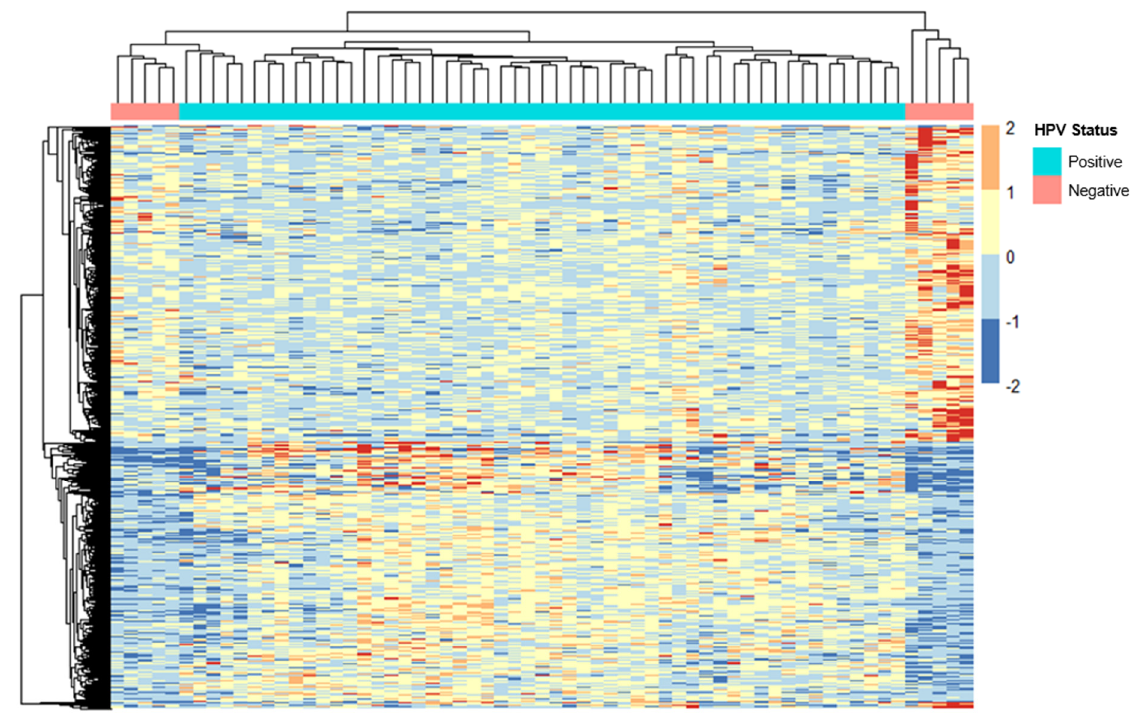
Figure 3. Transcriptome analysis of ERVs in HPV-positive and -negative cervical cancer patients. Heatmap generated using the normalized expression values for ERVs from the Human Endogenous Retrovirus database (HERVd). The plot above depicts the most significant ERVs ( p adj < 0.1) that were differentially expressed among samples with differing HPV diagnoses. The plot above depicts the most significant ERVs ( p adj < 0.1) that were differentially expressed among samples of different HPV status, i.e., positive (n = 53) and negative (n = 10). A complete list of differentially expressed ERVs is displayed in Supplementary Table S5. ERV expression is indicated by color intensity from − 2.0 to 2.0 on a log scale; red indicates ERVs with higher expression, and blue indicates ERVs with lower expression. HPV = human papillomavirus.